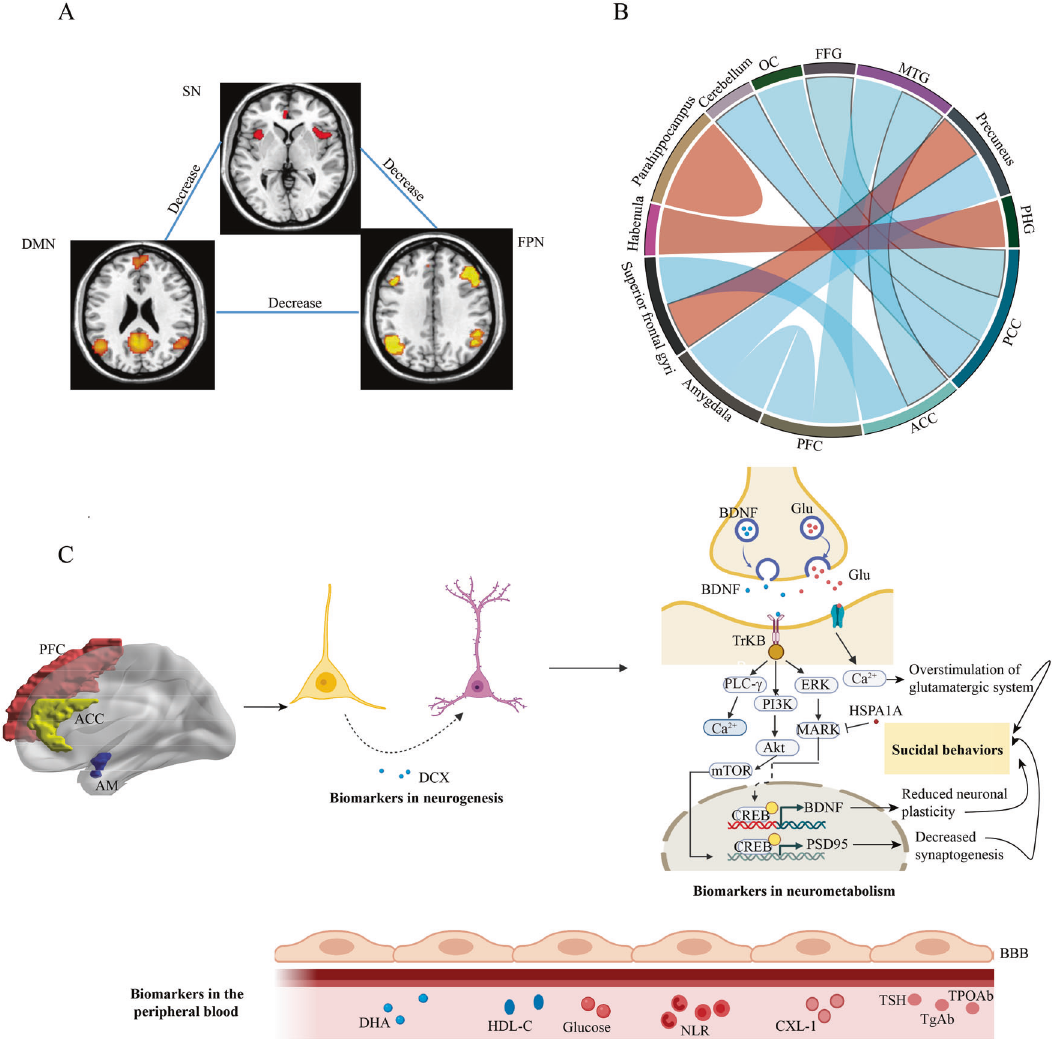
Fig. 4 Predictive biomarkers to differentiate MDD patients with and without suicidal attempts. A Functional connectivity (FC) differences in large-scale brain networks. The green line indicated the signi fi cant decrease of FC in MDD with suicidal ideation compared to MDD without suicidal attempts. B Increase (red color connections) or decrease (blue color connections) of FC changes in local brain regions for MDD patients with suicidal attempts compared to MDD without suicidal attempts. C Protein and metabolite biomarkers in brain regions and peripheral blood for the differentiation of MDD patients with and without suicidal ideation. Red dots indicated increased expression or concentration in MDD with suicidal ideation compared to MDD without suicidal attempts. Blue dots indicated decreased expression or concentration. SN, Salience network; DMN, Default mode network; FPN, Frontoparietal network; OC, occipital cortex; FFG, fusiform gyrus; MTG, middle temporal gyrus; PHG, parahippocampal gyrus; PCC, posterior cingulate cortex; ACC, anterior cingulate cortex; PFC, Prefrontal cortex; AM, amygdala; DCX, Doublecortin; BDNF, Brain-derived neurotrophic factor, Glu, Glutamate; HSPA1A, Heat shock protein family A member A; DHA, Docosahexaenoic acid; HDL-C, High-density lipoprotein cholesterol; NLR, Neutrophil-to-lymphocyte ratio; TSH, thyroid-stimulating hormone; TgAb, anti-thyroglobulin; TPOAb, thyroid peroxidases antibody; BBB, blood – brain